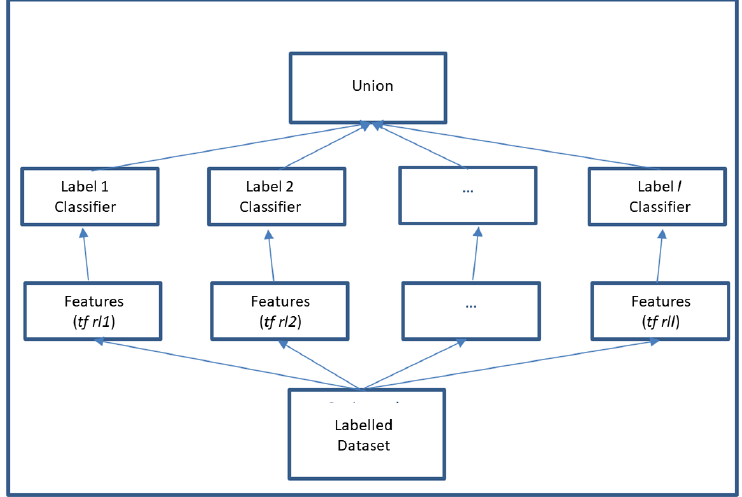
Figure 1. View as an